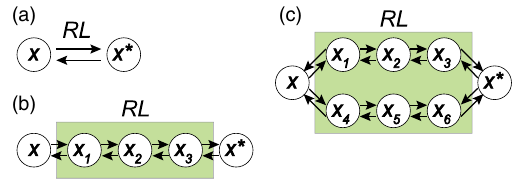
FIG. 4. Copy processes of increasing complexity. (a) A simple one-step process in which the RL -bound state is assumed short- lived. (b) A tightly coupled process in which the readout passes through multiple states while bound to the receptor, but only one pathway is possible. (c) A more general process in which multiple pathways between x and x (cid:2) exist. Each different path could be associated with different entropy increases in the